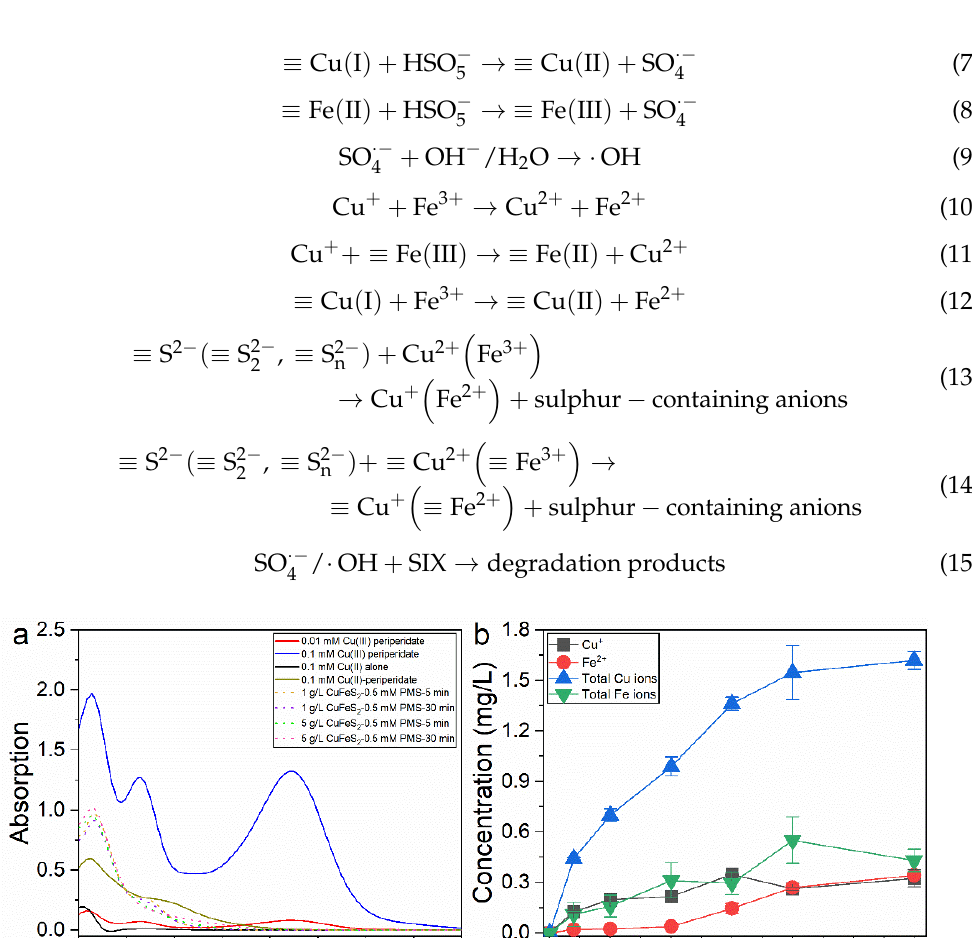
The difference between the concentrations of iron and copper ions in chalcopyrite–PMS oxidation.